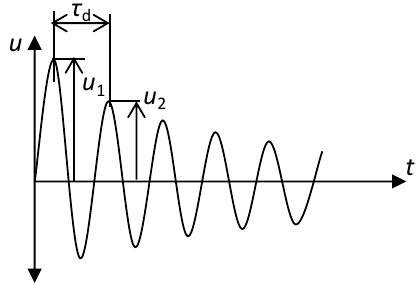
Figure 14. Rate of decay of oscillation measured by logarithmic decrement [41].